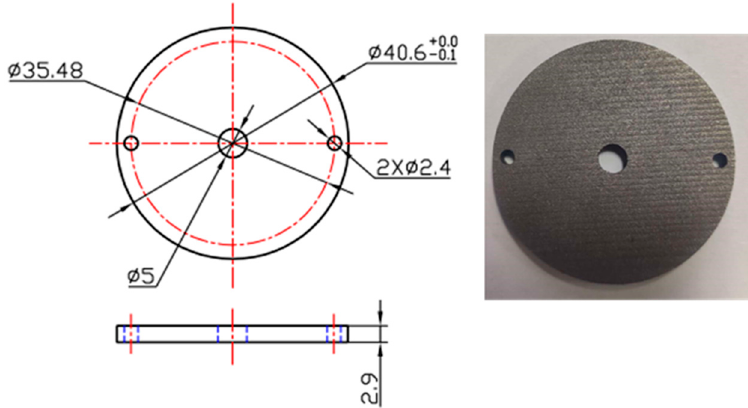
Figure 6. Standard specimens of 65Mn low-alloy steel for wear tests.